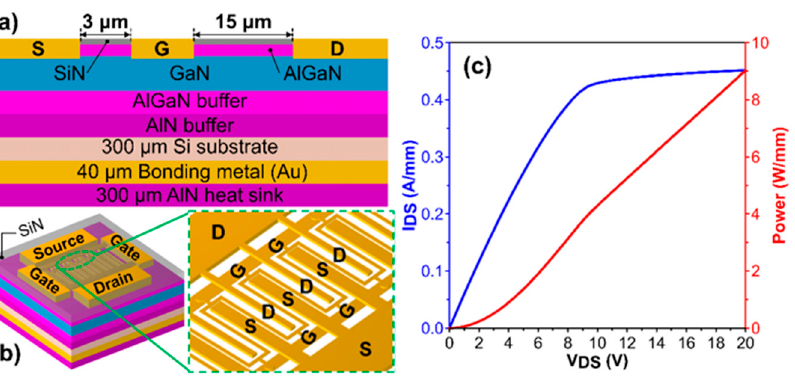
Figure 1. ( a ) Cross-sectional plot of a single GaN HEMT device. ( b ) The three-dimensional schematic of a multiple gate HEMT device. ( c ) The drain current–voltage curve and corresponding power density of a single GaN